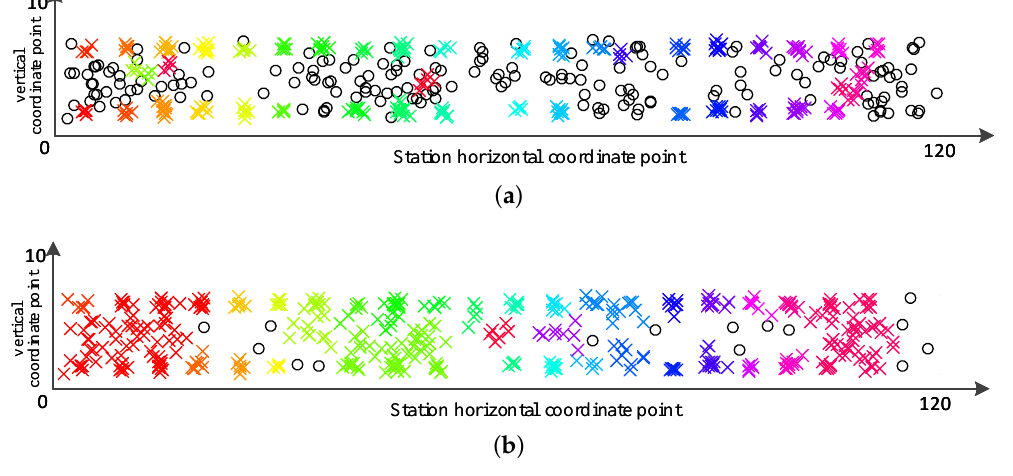
Figure 11. DBSCAN algorithm for passenger location data clustering effect chart ( a ) MinPts = 4, Eps = 1.0; ( b ) MinPts = 4, Eps = 1.5.